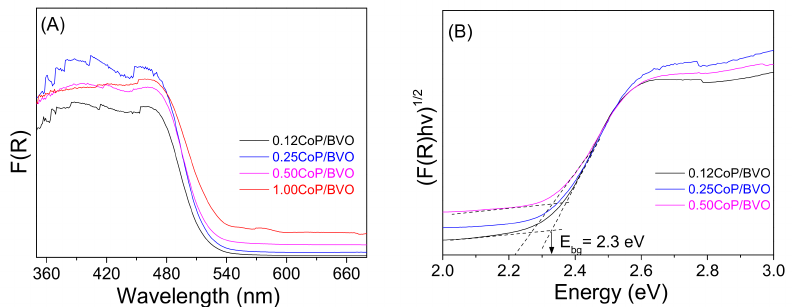
Figure 2. ( A ) UV-vis diffuse reflectance spectra and ( B ) Tauc plots obtained for CoP/BVO catalysts.